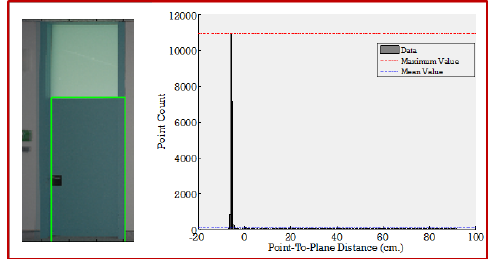
Figure 10: Histogram of point-to-plane distances: closed door segmentation in the second context.